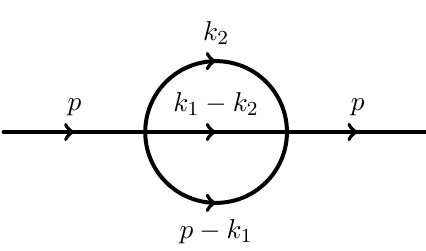
Figure 1 . Sunrise integral. All internal propagators are massive and we consider the most general case where all masses can be unequal. The momentum labeling is chosen such as to make the loop-by-loop Baikov representation easier to